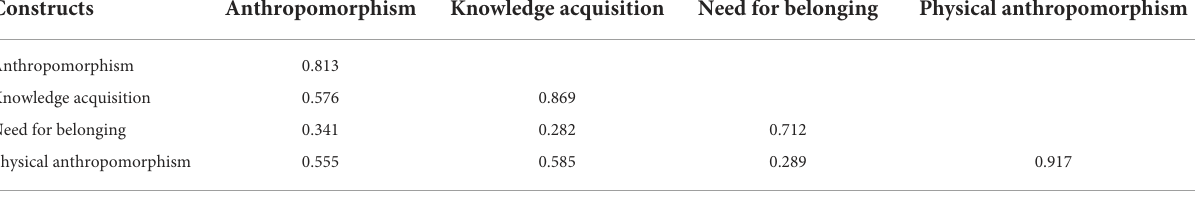
TABLE 3 Forenll-Lacker criteria for discriminant validity.